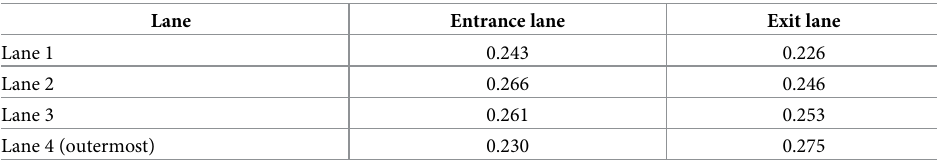
between the adjustment coefficient of saturation flow rate and proportion of lane changing by using the saturation flow rate of Group 1 as a benchmark, and the equation is shown in Eq (4). In Eq (4), the proportion of lane changing vehicles is the independent variable and it should be smaller than maximum value of the field data. It means the applicable range of P Table 5. Lane